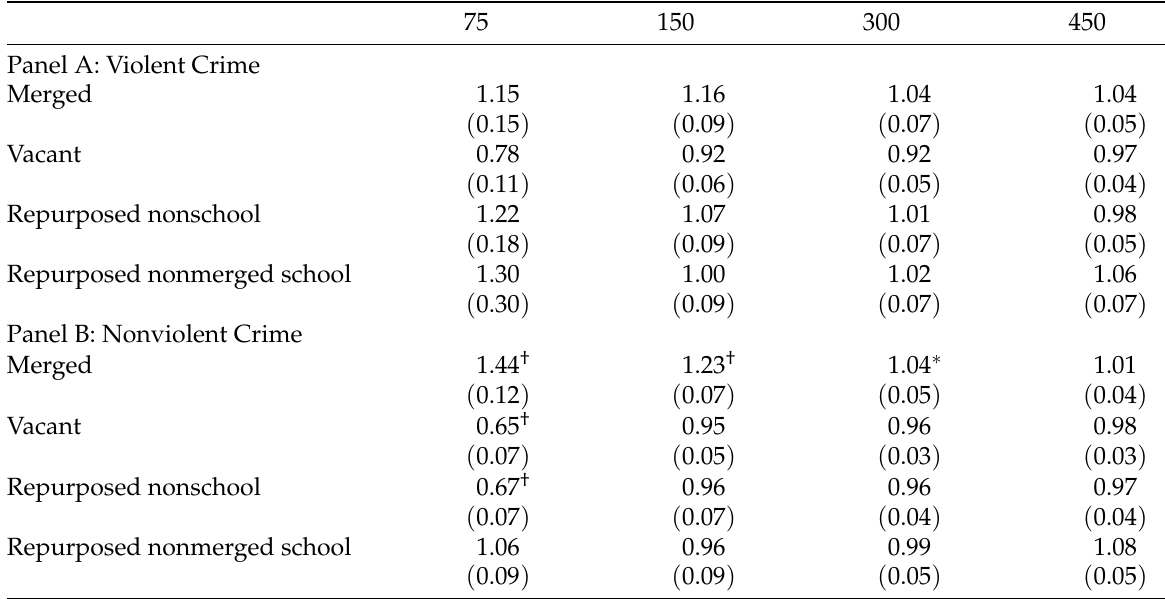
Table 3: Results from negative binomial regressions of violent and nonviolent crime counts on school closure condition by buffer radius.